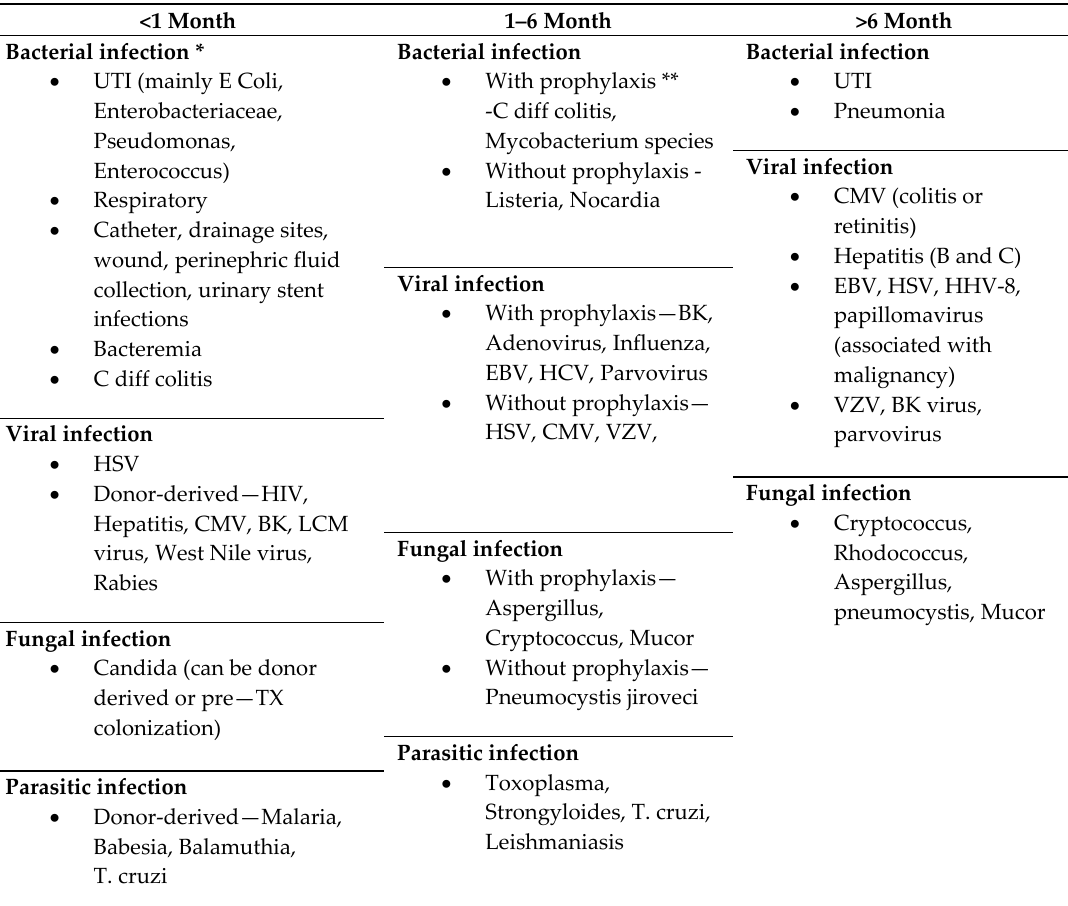
Table 3. Infection post kidney transplantation.